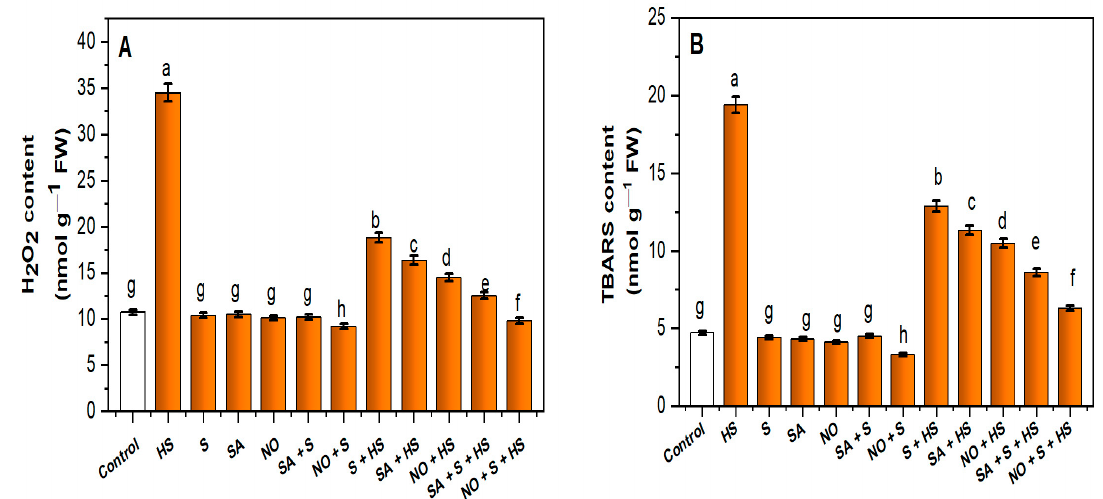
Figure 1. Content of ( A ) hydrogen peroxide (H 2 O 2 ) and ( B ) thiobarbituric acid reactive substances (TBARS) in wheat ( Triticum aestivum L.) cv. HD-3226 treated with 0.5 mM salicylic acid (SA) and/or 50.0 µM nitric oxide (NO)/2.0 mM SO 4 − 2 (S) individually or in combination in presence or absence of heat stress (HS; 40 ◦ C for 6 h daily for 15 days) at 30 days after germination. Data are presented as treatment mean ( n = 4). Data followed by the same letter are not significantly different by the LSD test at p ≤ 0.05. FW, fresh